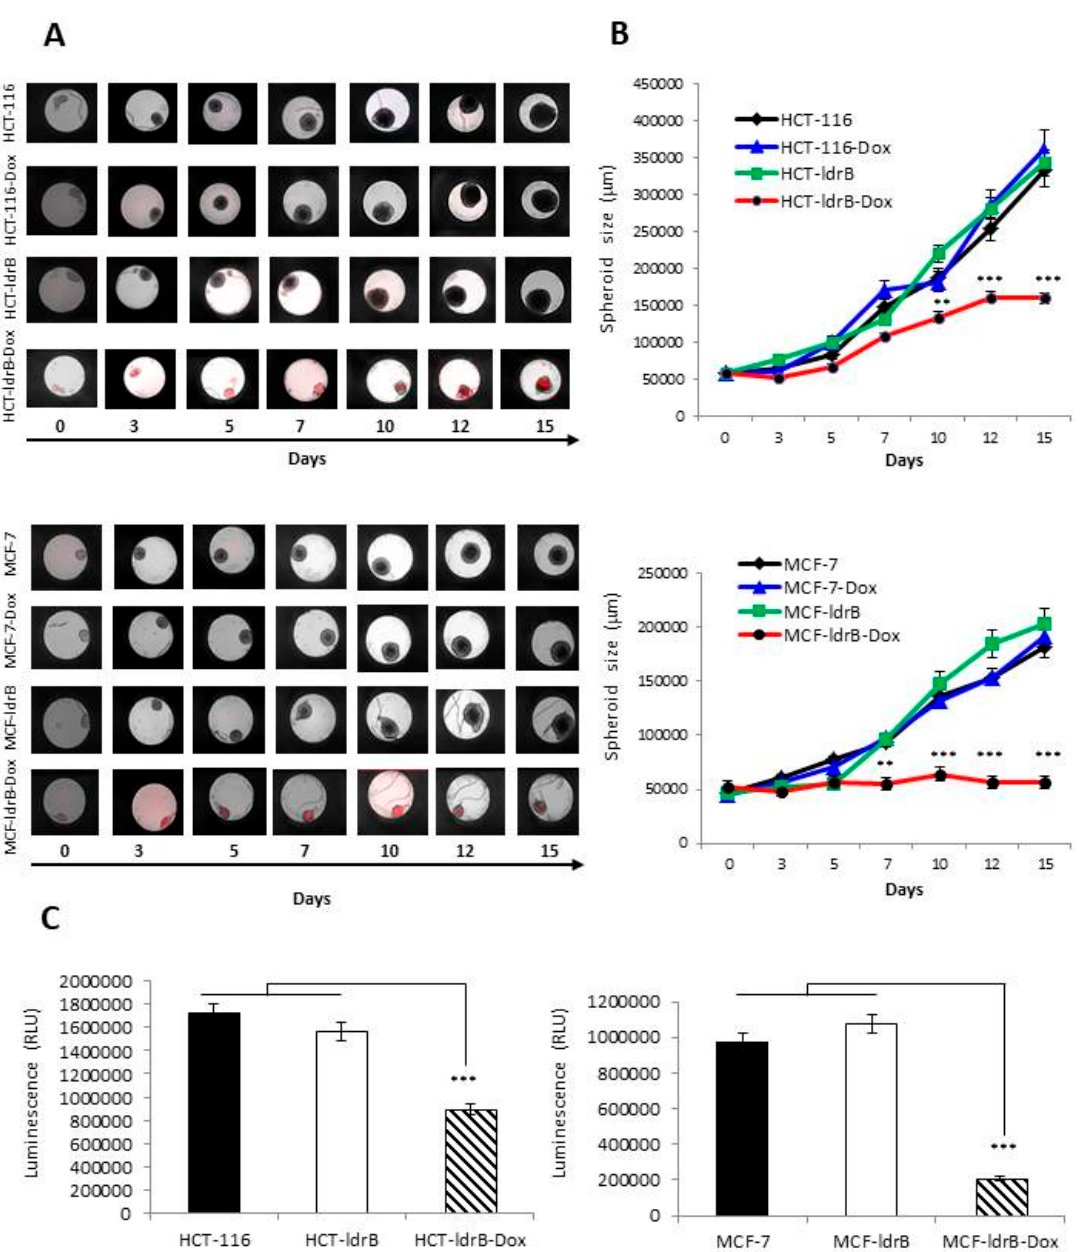
Figure2. ldrB geneexpressioninducesinhibitionofHCT-116andMCF-7spheroidproliferation.( A )HCT-116, Figure 2. ldrB gene expression induces inhibition of HCT-116 and MCF-7 spheroid proliferation. ( A ) HCT-116-Dox, HCT-ldrB, HCT-ldrB-Dox, MCF-7, MCF-7-Dox, MCF-ldrB, and MCF-ldrB-Dox spheroids HCT-116, HCT-116-Dox, HCT-ldrB, HCT-ldrB-Dox, MCF-7, MCF-7-Dox, MCF-ldrB, and were cultured for 15 d to determine the growth rate. Brightfield and fluorescence overlay images were MCF-ldrB-Dox spheroids were cultured for 15 d to determine the growth rate. Brightfield and obtained by an EnSight system with well imaging technology. ( B ) Size of HCT-116, HCT-ldrB, MCF-7, fluorescence overlay images were obtained by an EnSight system with well imaging technology. ( B ) and MCF-ldrB spheroids at di ff erent days (0, 3, 5, 7, 10, 12, and 15) of gene induction. ( C ) ATPlite Size of HCT-116, HCT-ldrB, MCF-7, and MCF-ldrB spheroids at different days (0, 3, 5, 7, 10, 12, and level of HCT-116, HCT-ldrB, and HCT-ldrB-Dox assessed by ATPlite-3D assay kit. Values represent 15) of gene induction. ( C ) ATPlite level of HCT-116, HCT-ldrB, and HCT-ldrB-Dox assessed by means ± SD of quadruplicate cultures (*** p < 0.001 vs. ATPlite-3D assay kit. Values represent means ± SD of quadruplicate cultures (*** p < 0.001 vs. control).